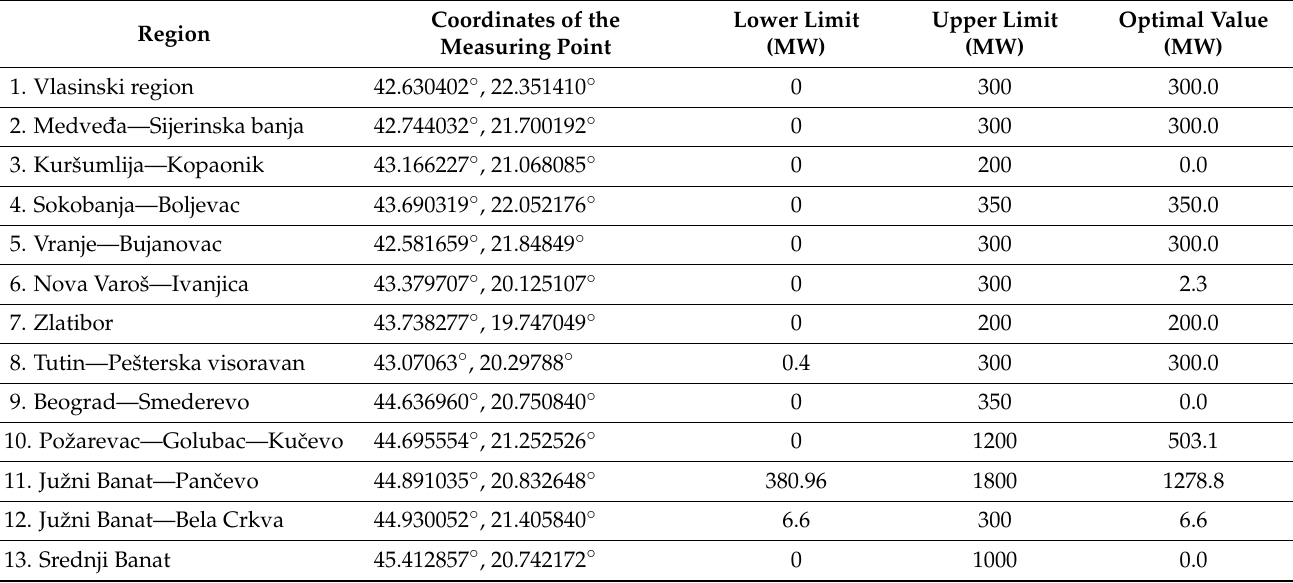
Table 1. Optimal capacities of WPPs in regions with technically exploitable wind resource.